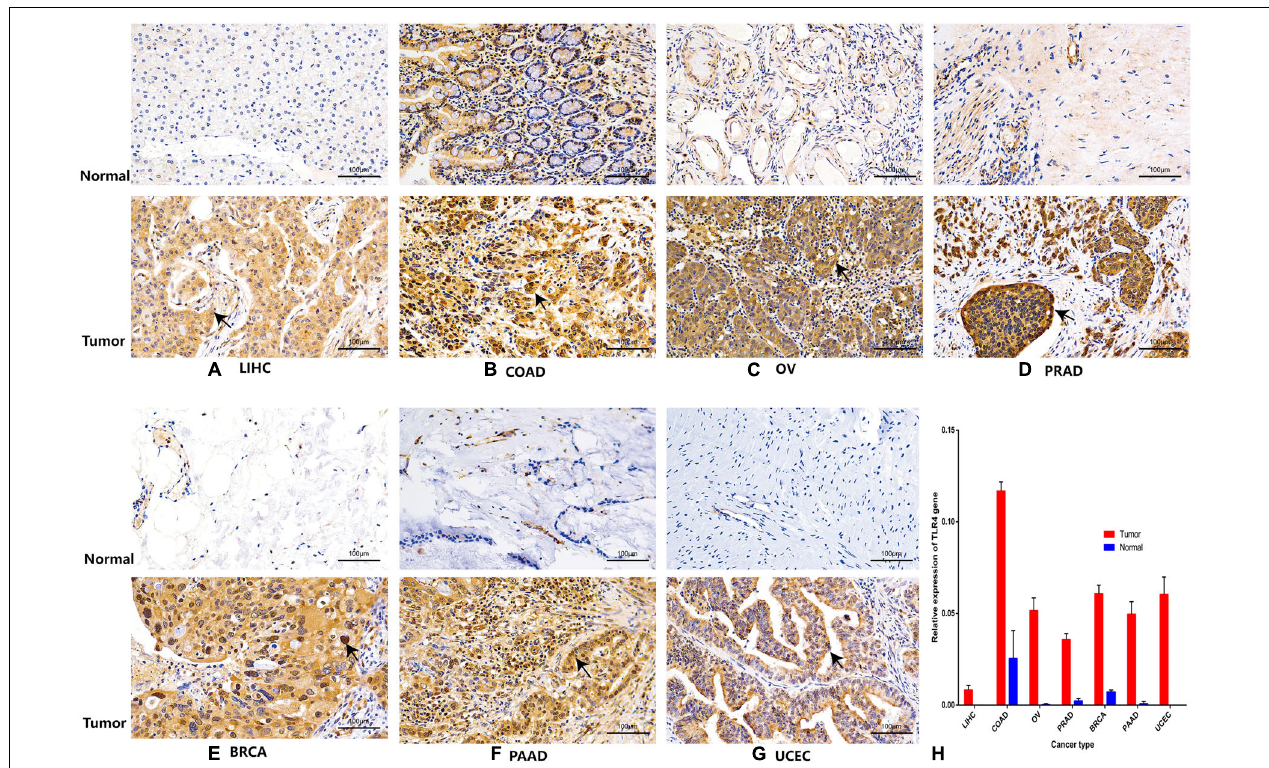
FIGURE 8 | Immunohistochemistry verifies the expression of TLR4 gene in seven tumors. The expression of TLR4 gene in LIHC (A) , COAD (B) , OV (C) , PRAD (D) , BRCA (E) , PAAD (F) , and UCEC (G) is significantly higher than that in the corresponding normal